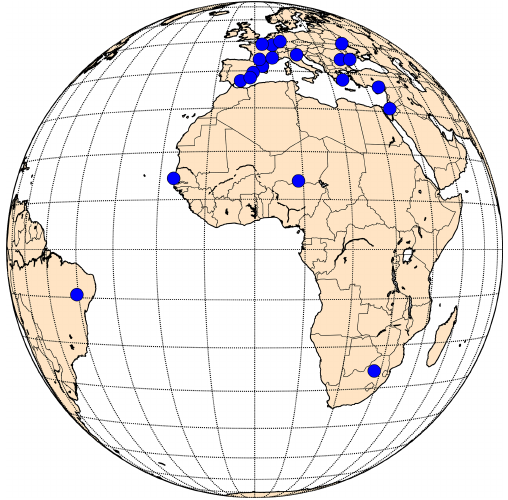
Figure 1. Locations of selected AERONET stations. All stations are located within the SEVIRI field of view. Table 1. AERONET